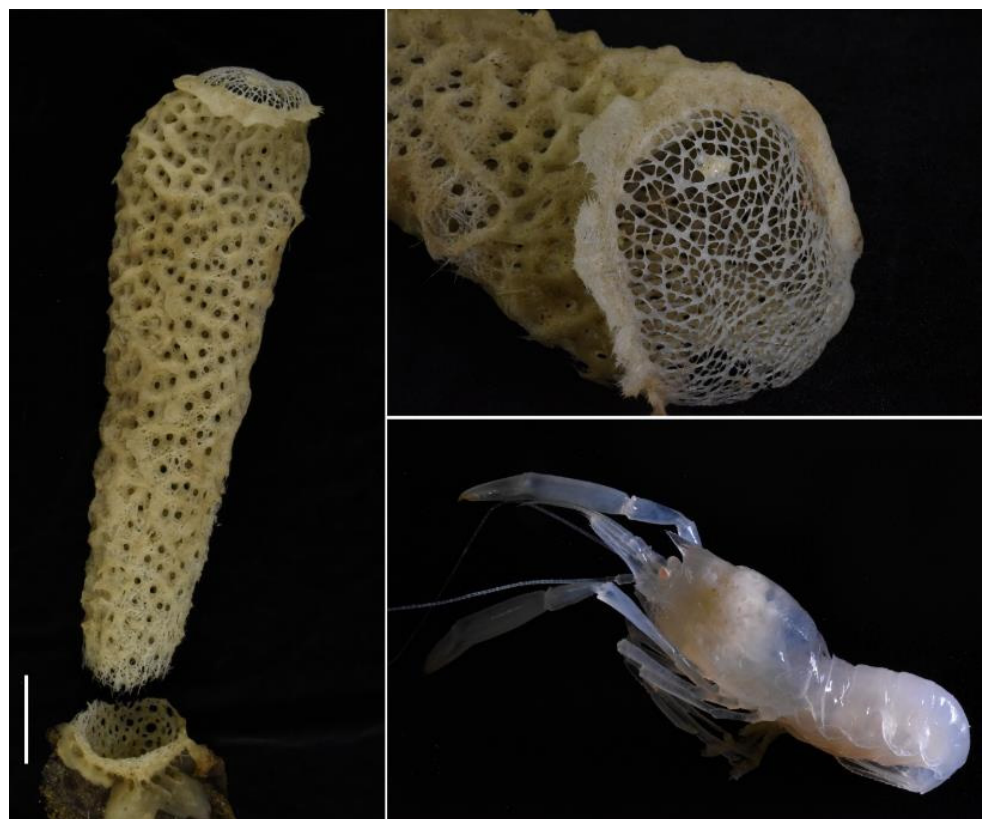
Figure 7. Spongicoloides clarki sp. nov., holotype F ov. (NIWA 118650) with euplectellid sponge host (NIWA 118649) collected off Macauley Island. Scale bar = 5 cm. Image credits: Rob Stewart, NIWA.